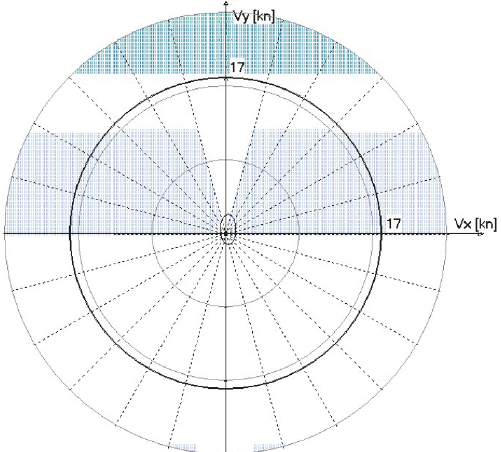
Figure 25: Sectors of own course and speed eliminated by risk of resonance (light blue) for wind of 20 [m/s] and wave from 180 ∘